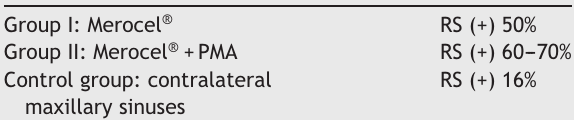
Incidence of rhinosinusitis in the groups of the study by Liang et al. (2008).